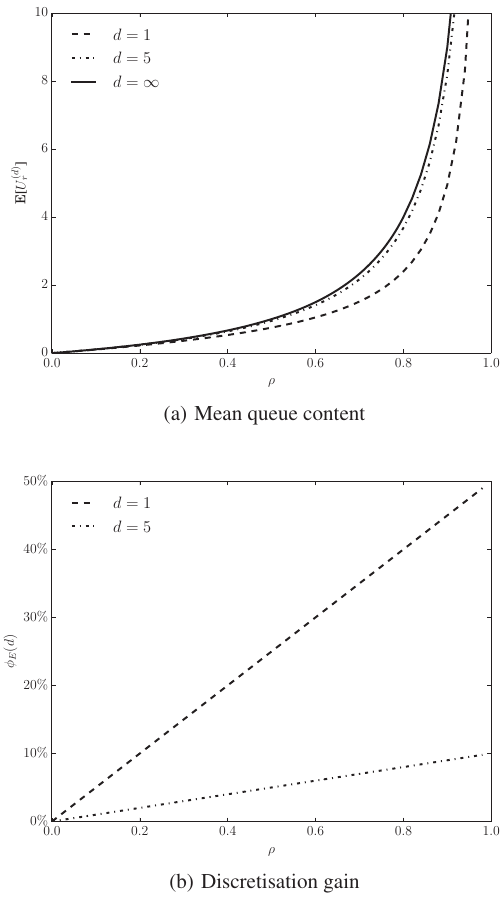
Figure 4: Mean queue content versus the load ρ (a) and the corresponding discretisation error (b) for different values of d and for the asynchronous queue ( d = ∞ )